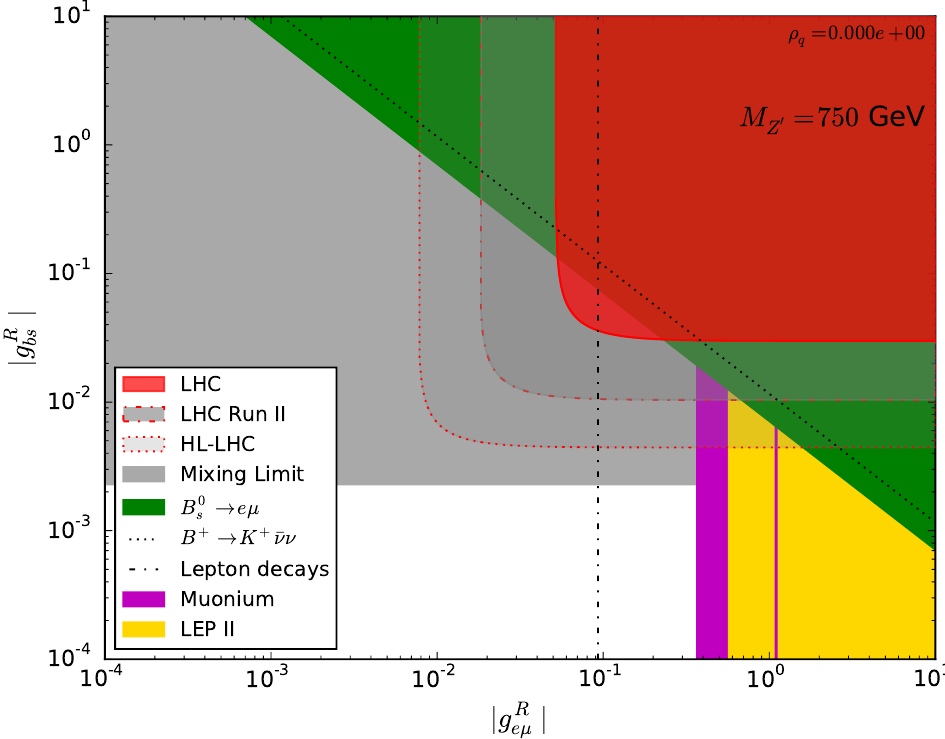
Figure 6 . The (cid:13)avor-violating couplings g R and g R for a Z 0 boson of M Z 0 = 750 GeV with purely e(cid:22) bs right-handed quark couplings ( (cid:26) q = 0). The red area indicates the limit from the ATLAS analysis p of the process pp ! e(cid:22) at s = 8 TeV. The red dash-dotted and dashed lines are projections to the LHC Run II and HL-LHC. The green area is the limit coming from the meson decay B 0 ! e(cid:22) . s The gold and magenta areas are purely leptonic limits coming from LEP and muonium oscillation constraints. The black dotted line is the neutrino exclusion limit from B + ! K + (cid:22) (cid:23)(cid:23) . The dash- dotted line originates from tests of lepton decays. However, these latter two limits only apply for left-handed lepton couplings. The gray area represents the B s (cid:0) (cid:22) B s mixing limit.